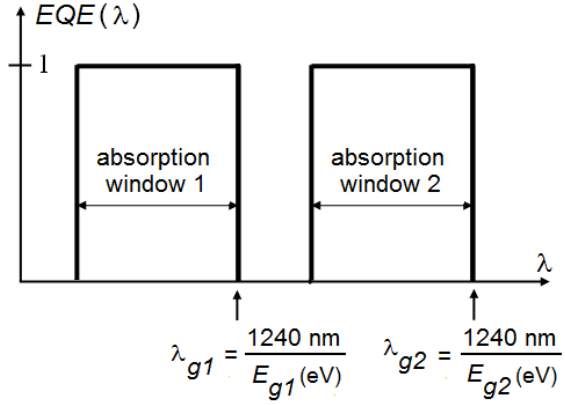
Figure 3. External quantum efficiency ( EQE ) as a function of the wavelength  . Definition of the absorption window and the cut-off wavelengths  and second subcell can be changed if there is no overlap between both absorption